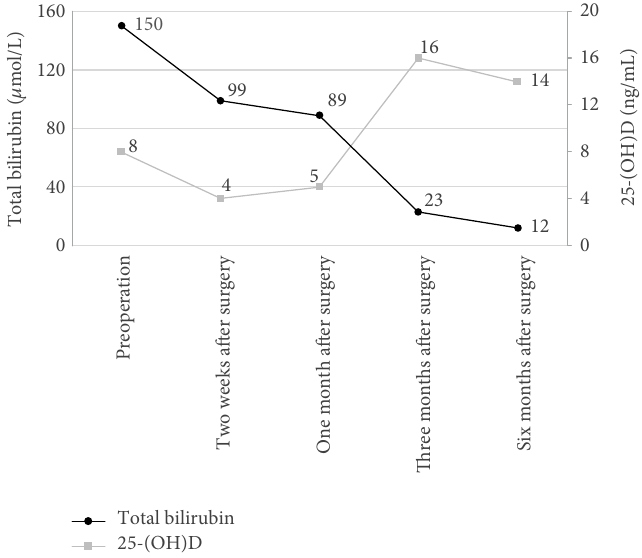
Figure 3: Relationship between 25-(OH)D level and bilirubin change before and after surgery in patients with BA. The median serum 25- (OH)D level was 7.66, 3.04, 5.13, 15.55, and 13.91ng/ml before surgery, 2 weeks after surgery, and 1, 3, and 6 months after surgery, respectively. After adjustment for the time variable, the 25-(OH)D level was negatively correlated with the TB level, suggesting that the uptake and metabolism of 25-(OH)D were remarkably improved after the serum TB level decreased after